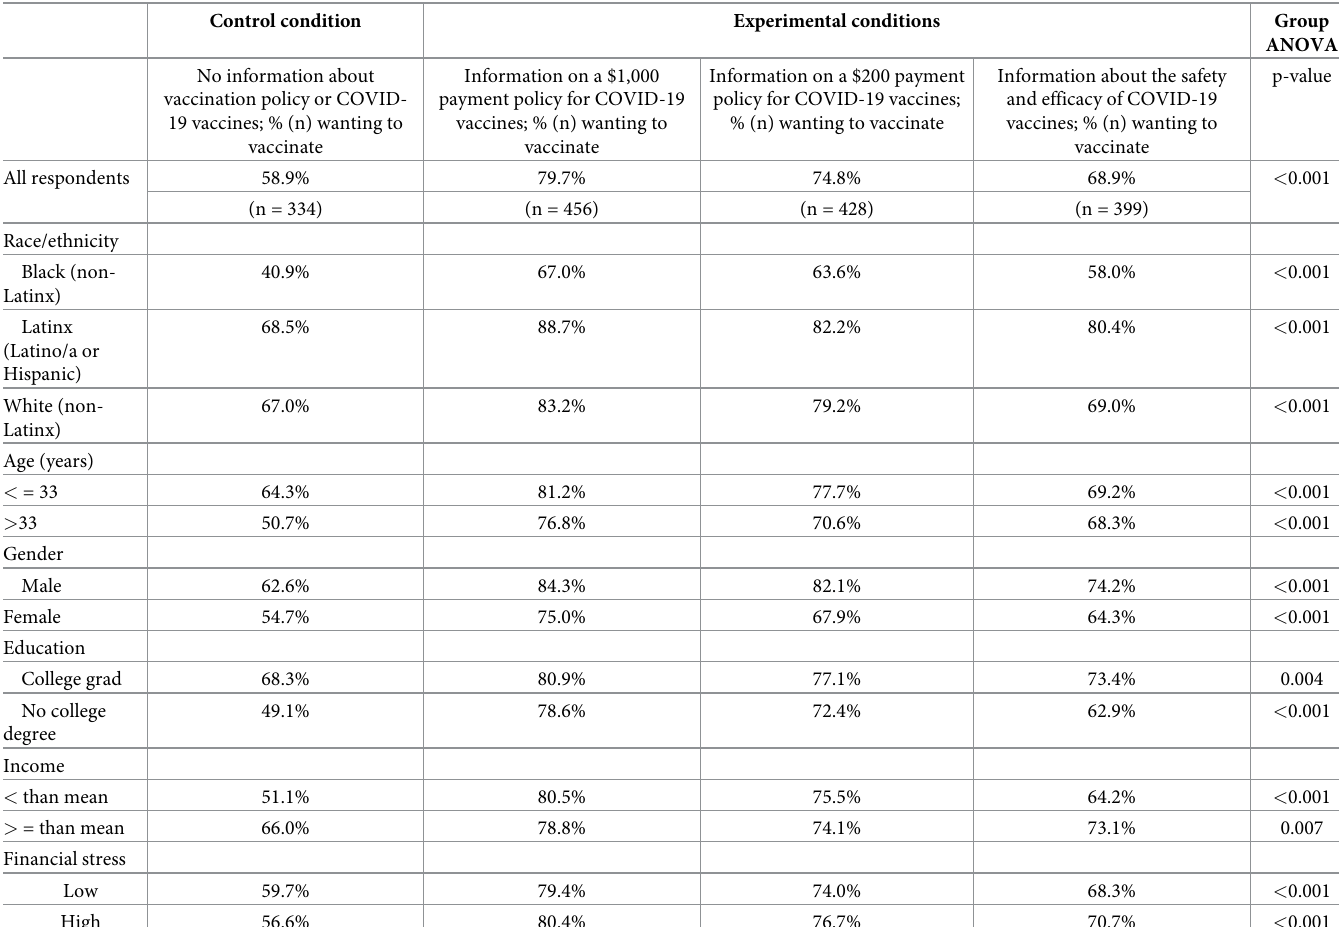
Table 2. The frequency and percentage of those who want to vaccinate in each condition.